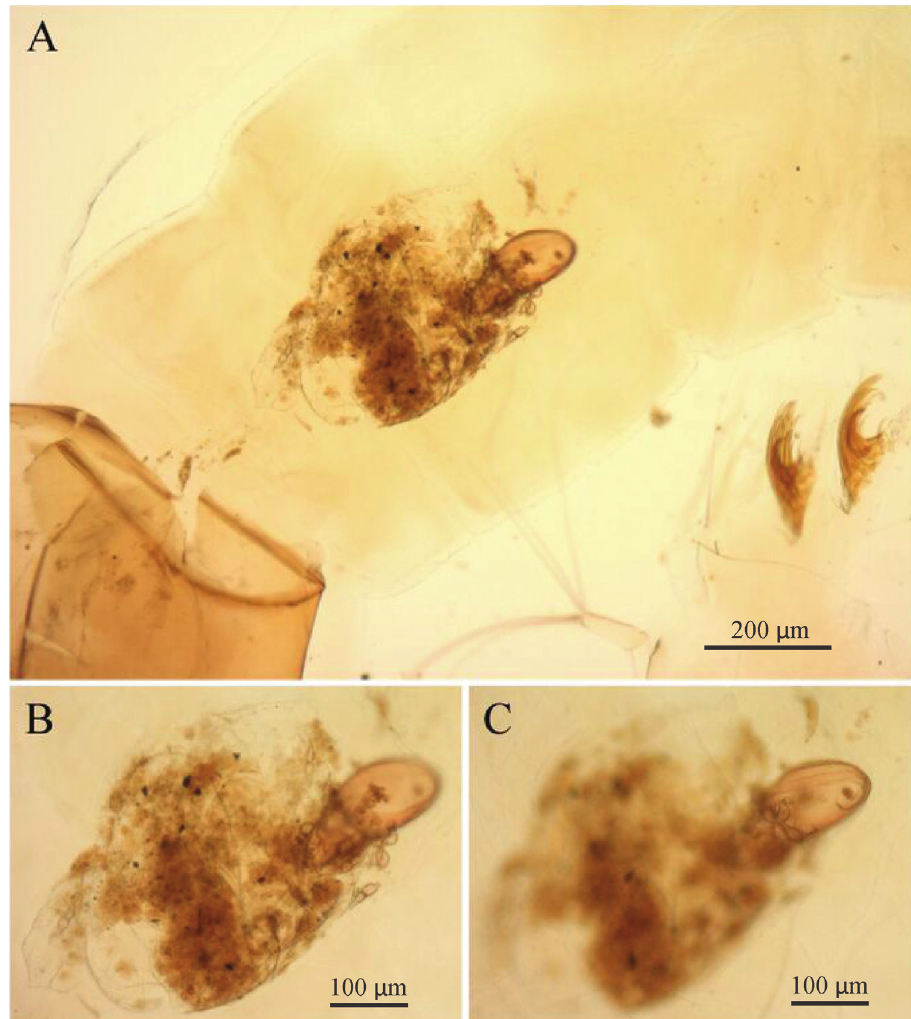
Figure 3. A–C Teratopiidae (Acariformes: Sarcoptiformes) found in gut contents of four specimens of Tanypodinae